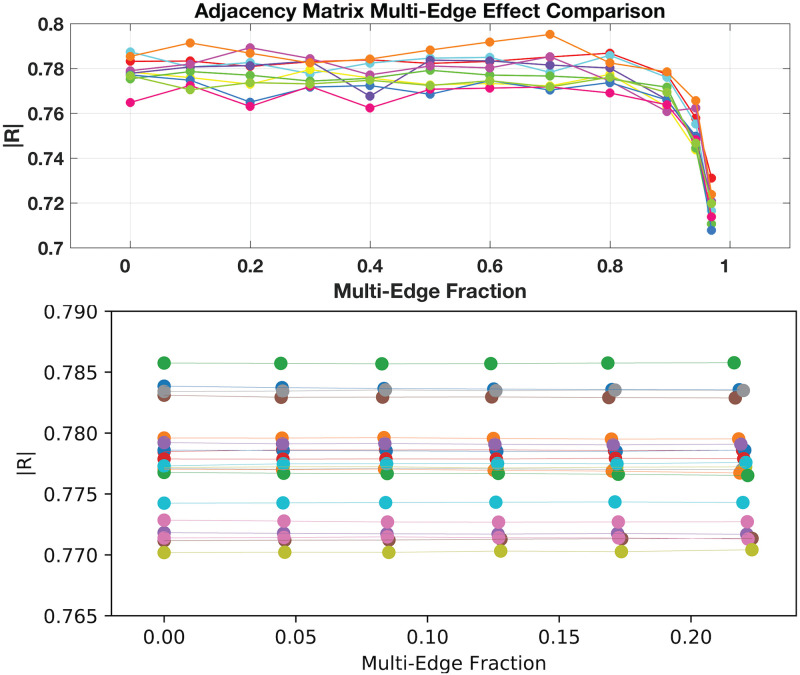
Illustration of multi-edge influence proportion on synchronisation parameter (|R|) for neuronal network, sized N = 5000.Overall little influence of multi-edges arises until quite high densities occur at around 90% (Upper Pane) as produced by the permutation method. Networks constructed via the Configuration Method (Lower Pane) that arbitrarily generate up to around 20% total multi-edges instead show no effect over range of multi-edges removed via post-processing. Note, the two results presented are via different solution techniques: the upper pane solution of full suite of equations, the lower with a mean-field approximation (see Appendix). Each curve corresponds to a unique realisation of excitability parameter suite for group of N neurons in simulation. Generation of individual adjacency matrices, A, were performed with degree sequences produced via power-law distribution exhibiting neutral correlation between in- and out- degrees ranging over kin, kout ∈ [750, 2000]. See Appendix for more details of the neuronal network simulation.